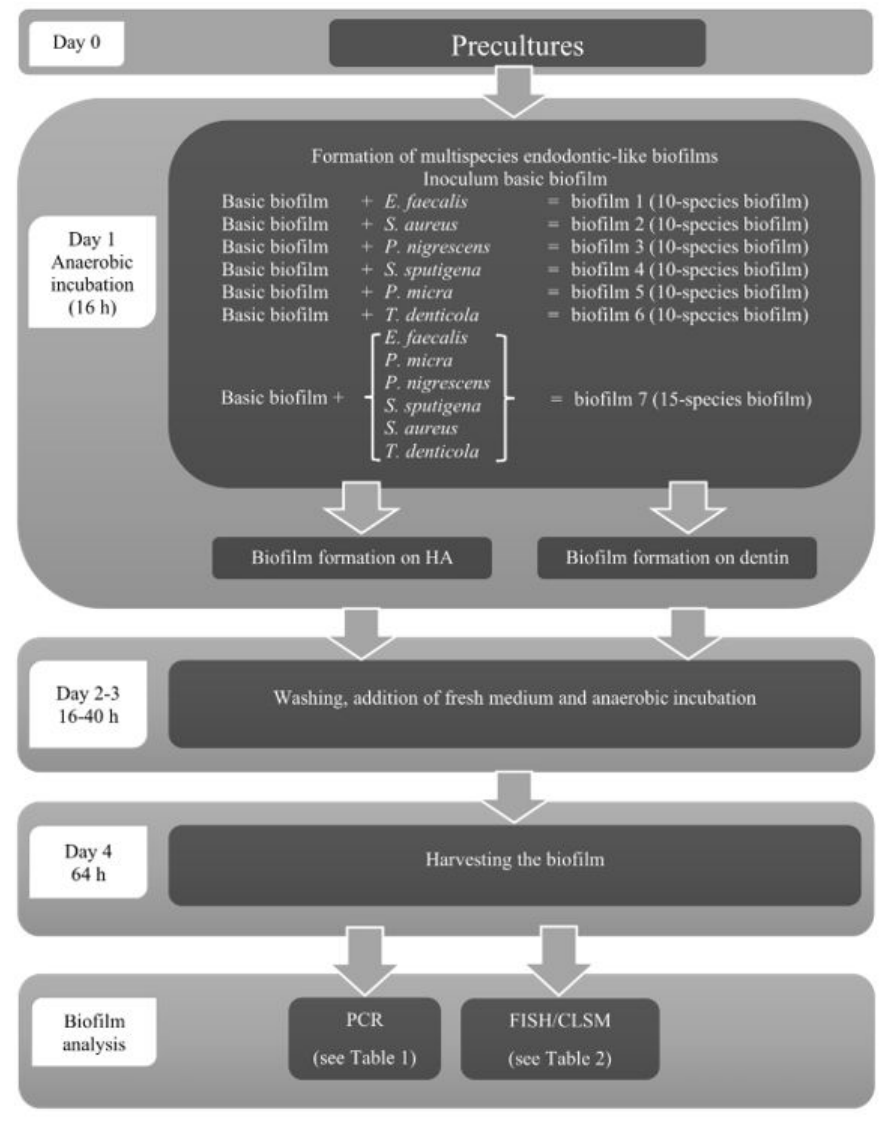
Figure 1. Endodontic-like biofilm formation and analysis using PCR and FISH /